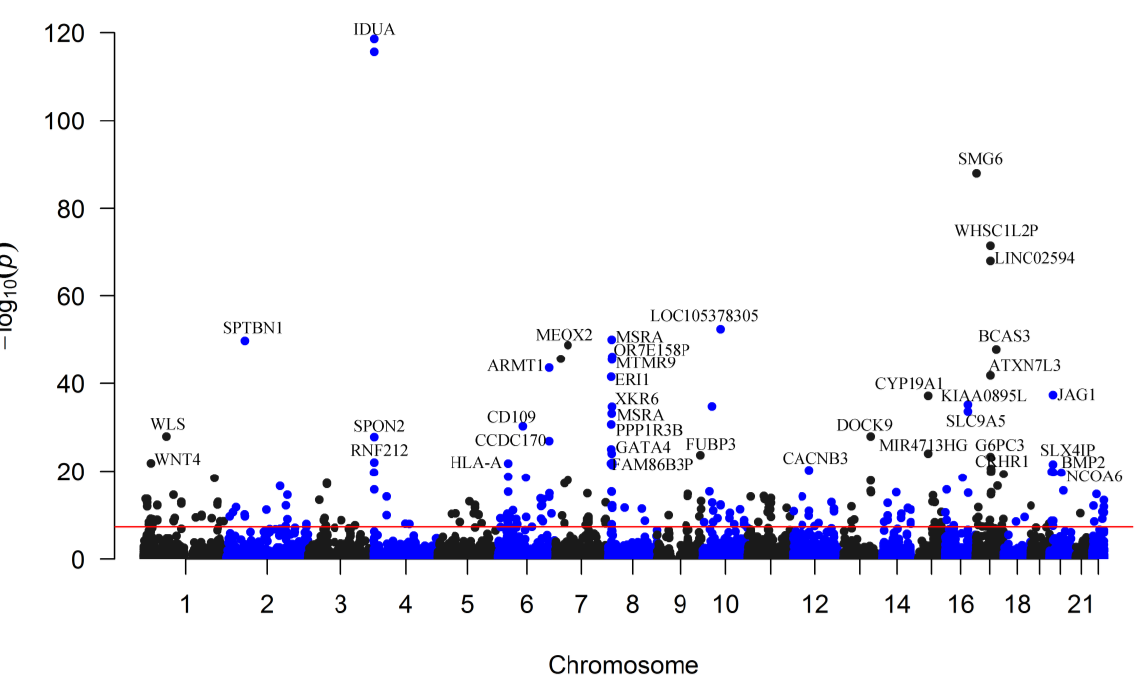
Figure 1. Genome-wide distribution of the identified eBMD-associated m 6 A-SNPs. The Manhattan plot shows the associations between m 6 A-SNPs and eBMD. The x-axis indicates chromosome posi- tions. The y-axis indicates − log 10 p values of the associations. The red line indicates the genome-wide significance level of 5.0 × 10 − 8 .